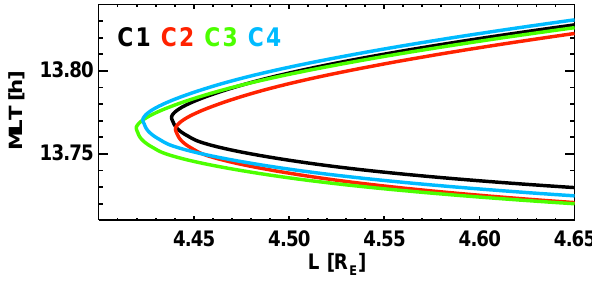
Fig. 5. Magnetic local time of Cluster orbit plotted against the L